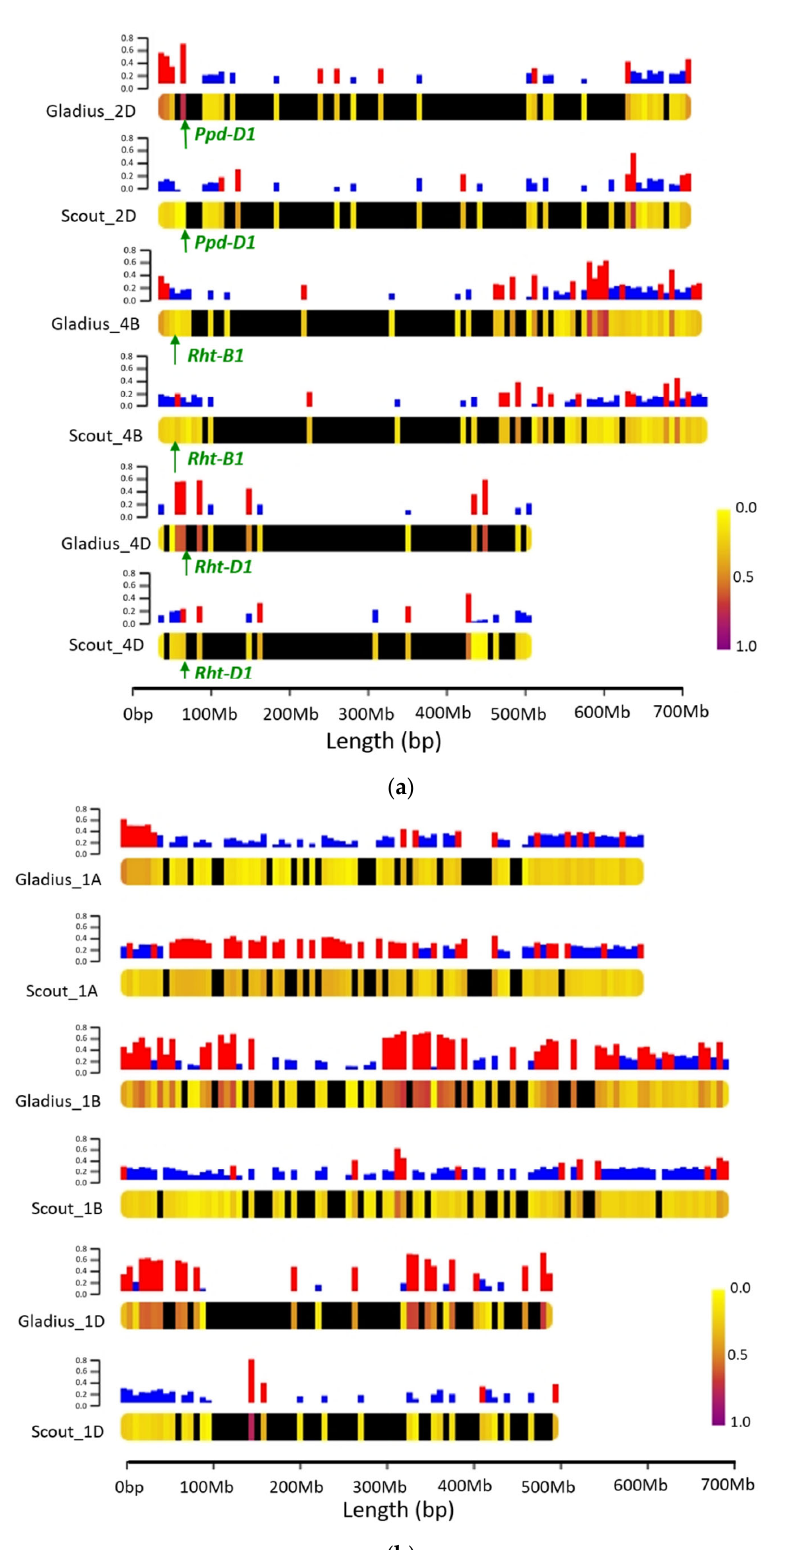
Figure 3. Chromosome heat maps showing proportions of exotic and reference parent alleles on different chromosomes: ( a ) Chromosomes 2D, 4B and 4D. The loci for relevant genes are indicated; ( b ) Chromosome 1. Bars on top of